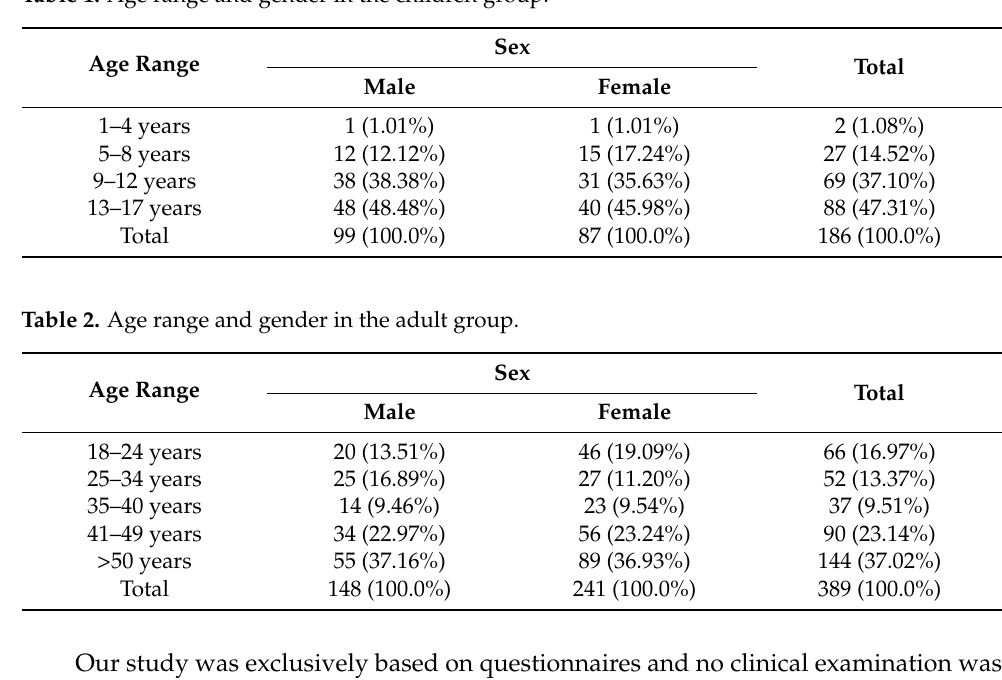
Table 1. Age range and gender in the children group.